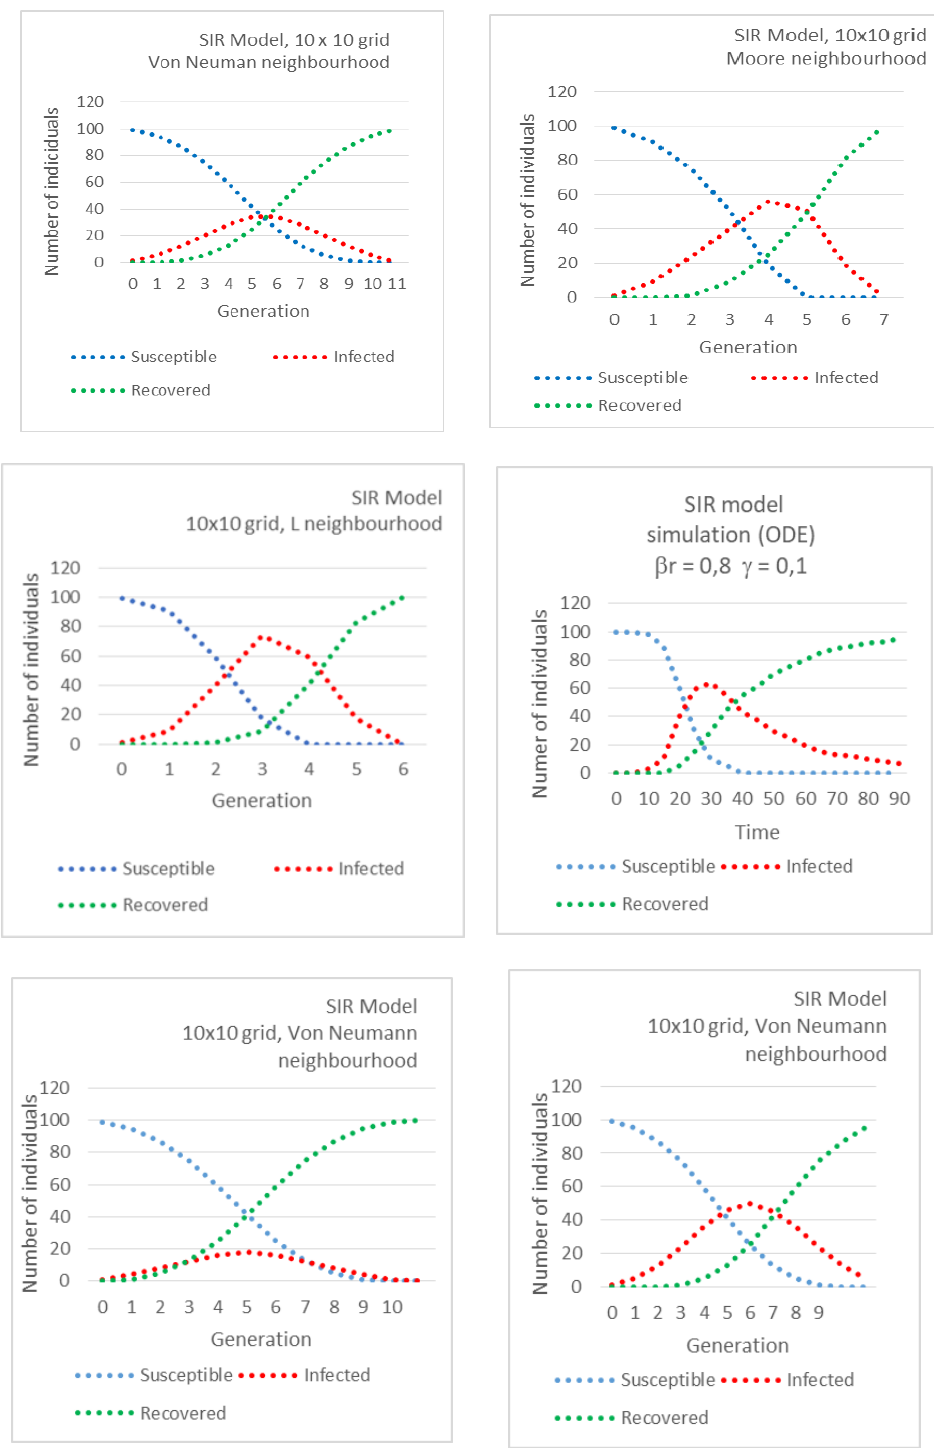
Figure 2. Number of Susceptible, Infected and Recovered vs. time (generation) in the case of an Susceptible-Infected-Recovered (SIR) model, for different neighborhoods .